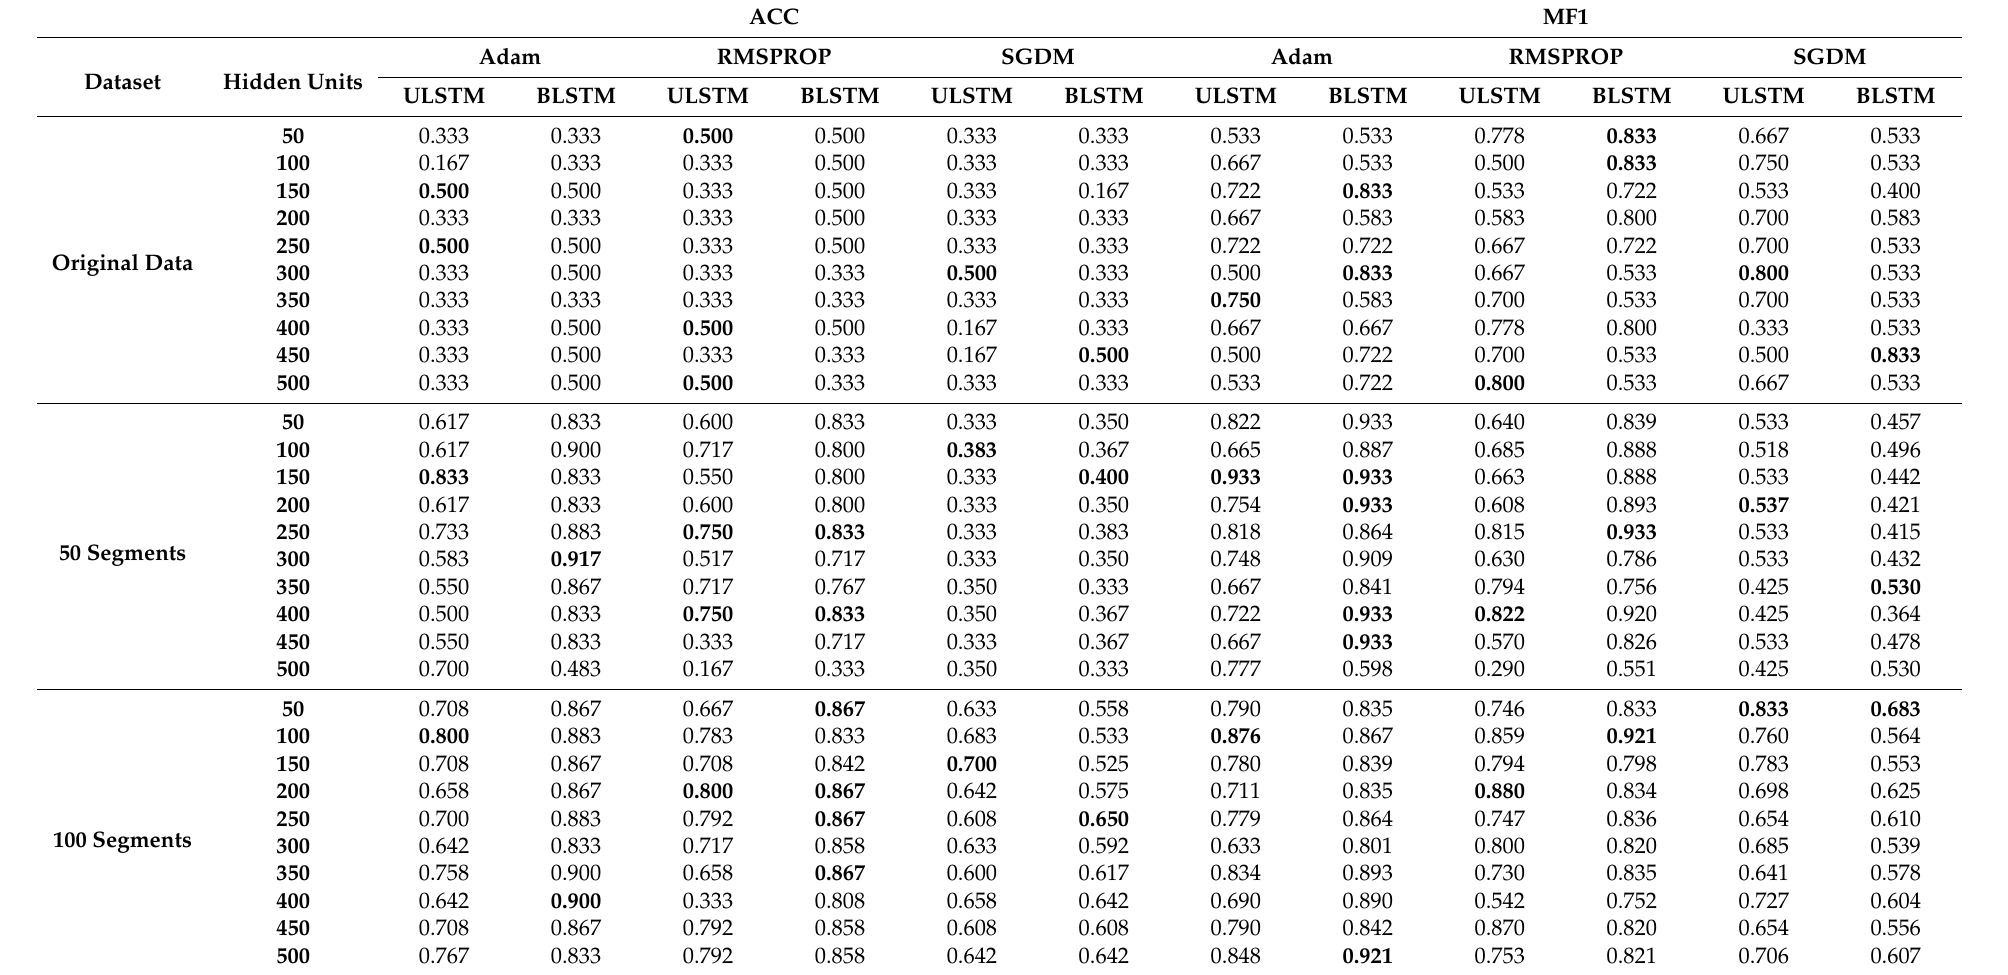
Table 10. Performance metrics of the test data from the networks trained with the 31-mer Oestrdiol dataset. ACC MF1